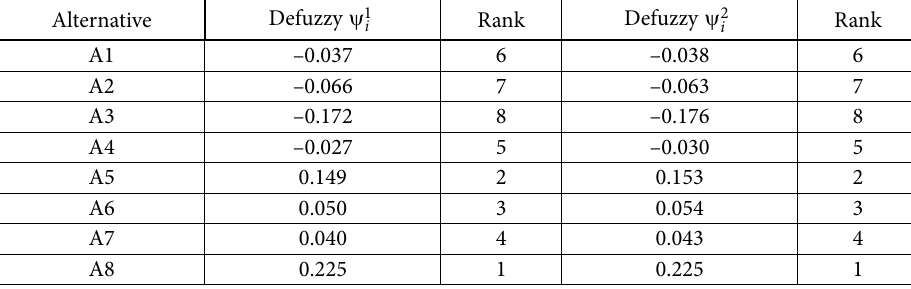
Table 12. Final ranking results of the fuzzy MABAC